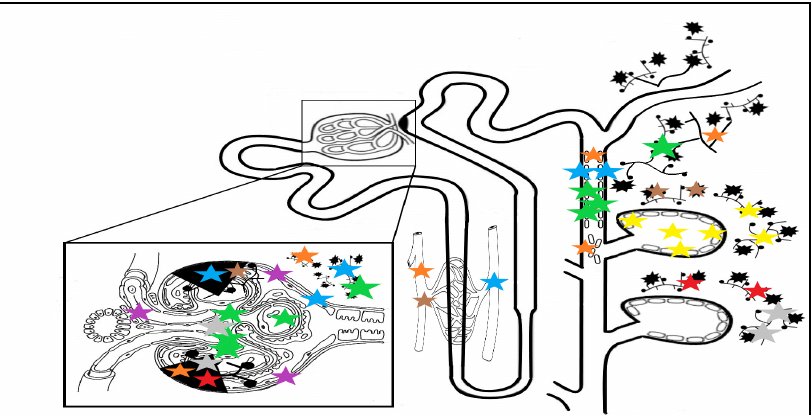
Figure 2. Nephronal sites of periostin staining depending on underlying disease: yellow stars indicate staining in ADPKD in cyst fluid, ECM and epithelial cyst cells [42]; blue stars indicate impregnation in DN in glomerulosclerosis areas, periglomerular fibrosis and ECM, atrophic tubules, around fibrotic vessels, and in Bowman’s capsule [24,40]; green stars indicate IgAN staining: in all nephronal sites, especially in the mesangium, periglomerular fibrosis, tubular cells, and casts and interstitial fibrosis; grey and red stars indicate MN and FSGS staining, occurring in fibrotic and glomerulosclerosis areas, with staining in the mesangium only for MN [26]; a similar staining pattern with a more pronounced expression in the glomerular and interstitial vascular compartments can be seen in hypertensive nephropathy, in the brown stars topography [22]; staining in lupus nephritis patients (orange stars) occurs in fibrotic vessels, tubular epithelial cells and tubular cells casts, in areas of interstitial fibrosis, and in the sclerotic glomerular and periglomerular sites [41]. The purple stars indicate staining in the nephrons of patients without kidney disease, with minimal vascular pole and Bowman capsule staining, sparing the tubulo-interstitium [26]. Abbreviations: ADPKD: autosomal dominant polycystic kidney disease; ECM: extracellular matrix; DN: diabetic nephropathy; IgAN: IgA nephropathy; MN: membranous nephropathy; FSGS: focal segmental